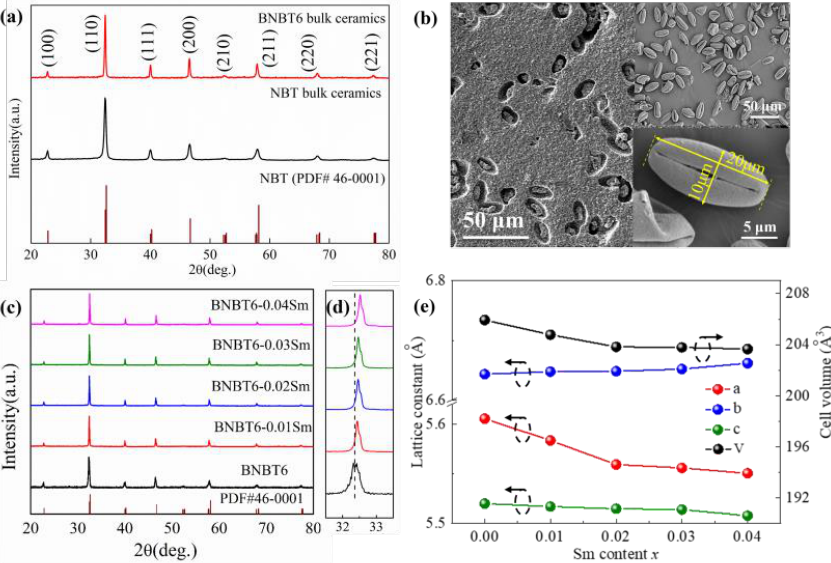
Figure 1. ( a ) XRD patterns of NBT and BNBT6 ceramics at 20°–80°. ( b ) SEM image of porous BNBT6 ceramic with 10 wt.% pollen, and the embedded graph is the SEM image of kiwi pollen. ( c ) XRD patterns of porous BNBT6- x Sm ceramics at 20°–80°. ( d ) XRD patterns of 32°–33°. ( e ) The lattice parameters of porous BNBT6- x Sm ceramics.